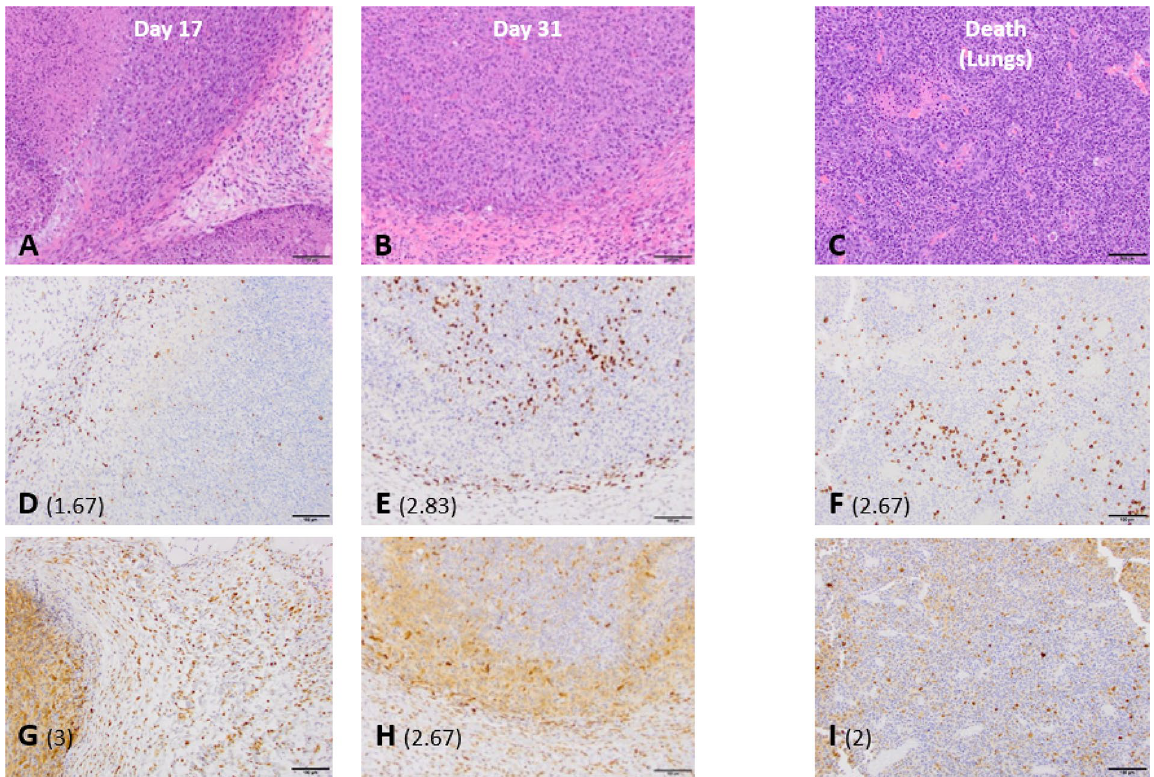
Figure 4. Tumor and lung histology analysis showing evolving immune reaction at tumor site following sub- ablative vascular-targeted photodynamic therapy. Semi-quantitative score (shown in parentheses) indicates the number of positive cells infiltrating tumor and peri-tumoral tissues, on a scale of 0 (no positive cells) to 4 (large number of positive cells). CD3 + is shown in ( D – F ), and Mac2 in ( G – I ), with both cell types observed in the same region. ( A , B ) Display results of hematoxylin and eosin (H&E) stain, showing skin, subcutis, and muscle with subcutaneous neoplasm. Note the chronic-active inflammation of tumor and adjacent tissues. ( D , E ) display results of CD3 + stain, illustrating time-dependent accumulation of T-cells. ( G , H ) display results of Mac2 (galectin 3) stain, illustrating initial accumulation of macrophages and dendritic cells followed by gradual decline. Lungs showed metastatic foci on H&E ( C ), aggregation of T-cells (CD3 + stain, F ), and macrophages and dendritic aggregation ( I